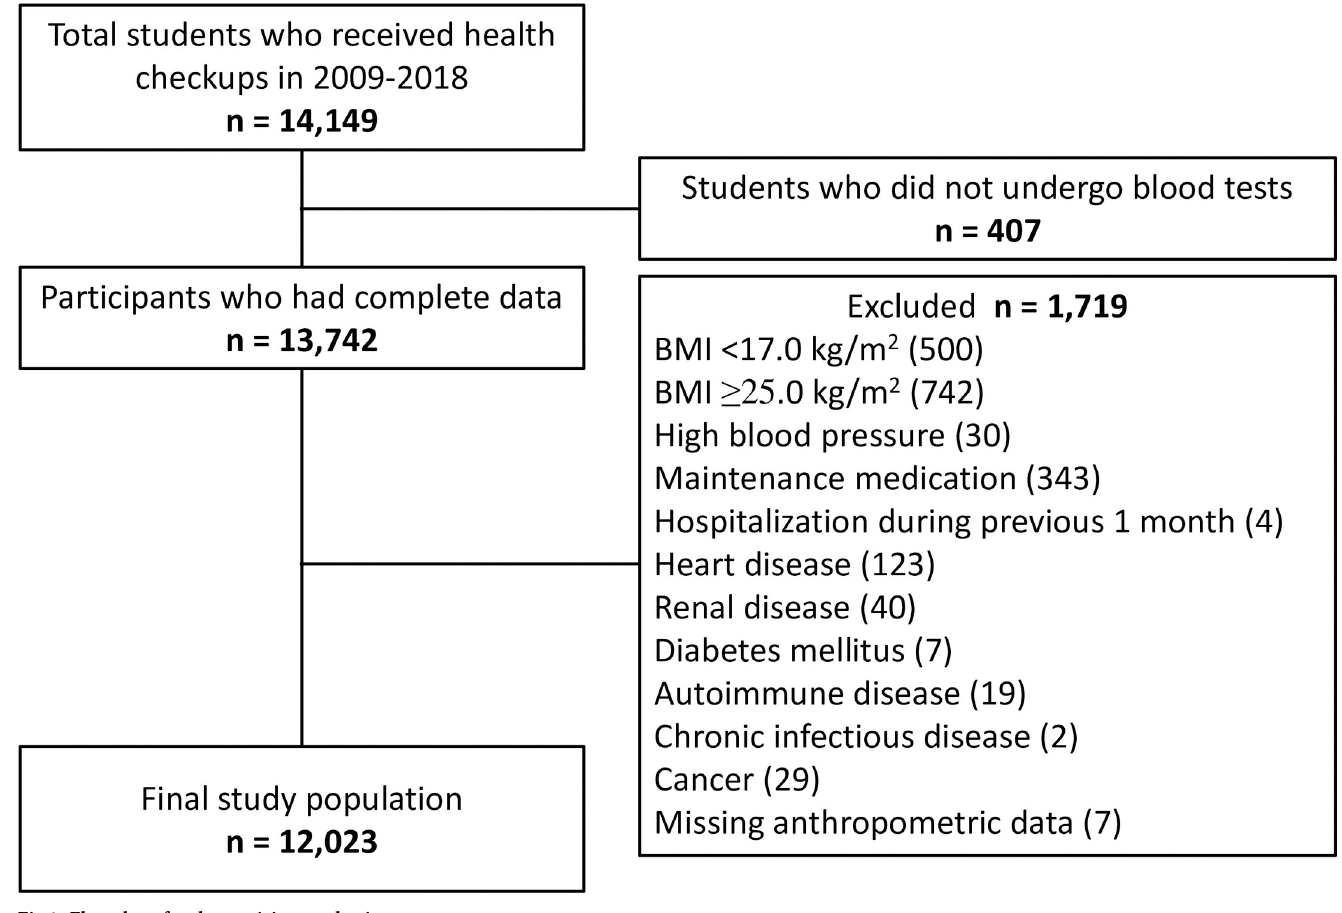
Fig 1. Flow chart for the participant selection.